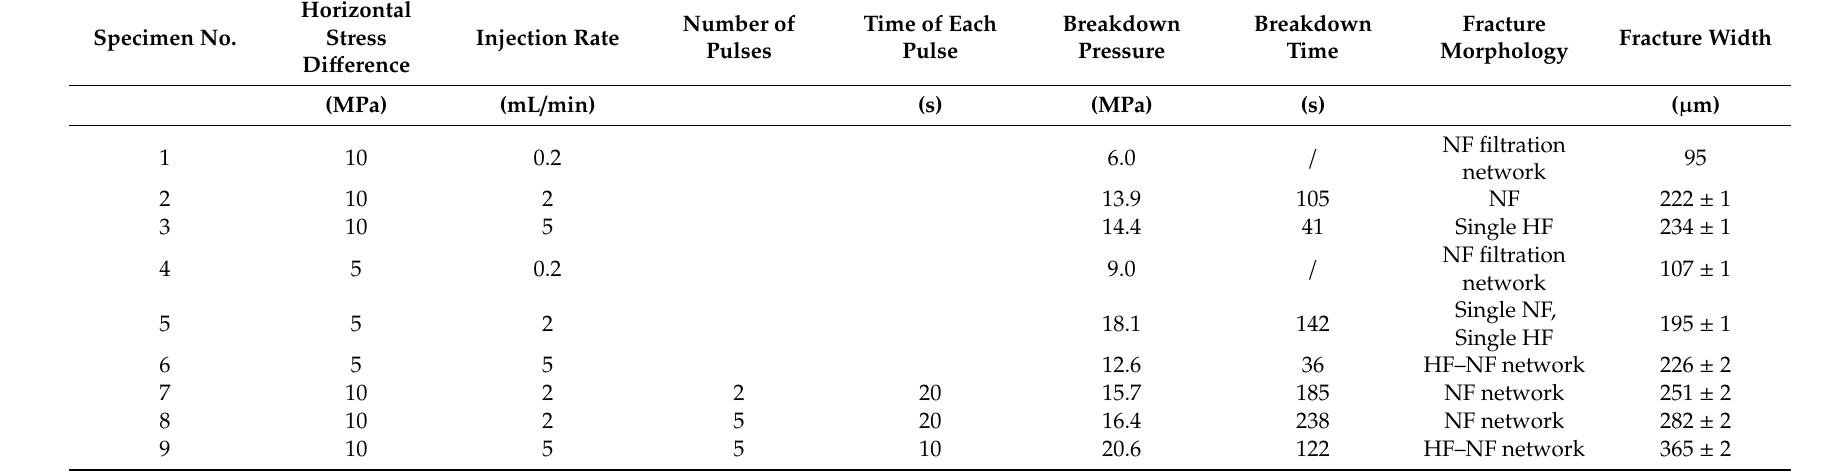
Table 1. Experimental parameters and overall